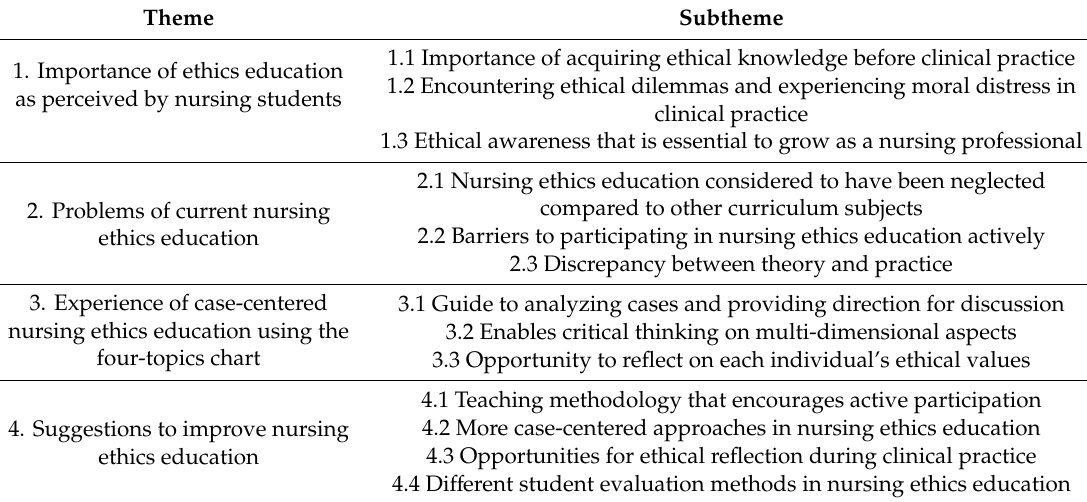
Table 3. Major themes and